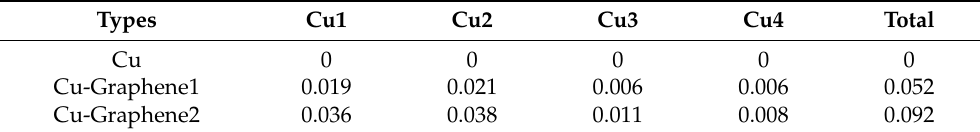
Table 2. Charge distribution of three types of copper electrode plates (Unit: